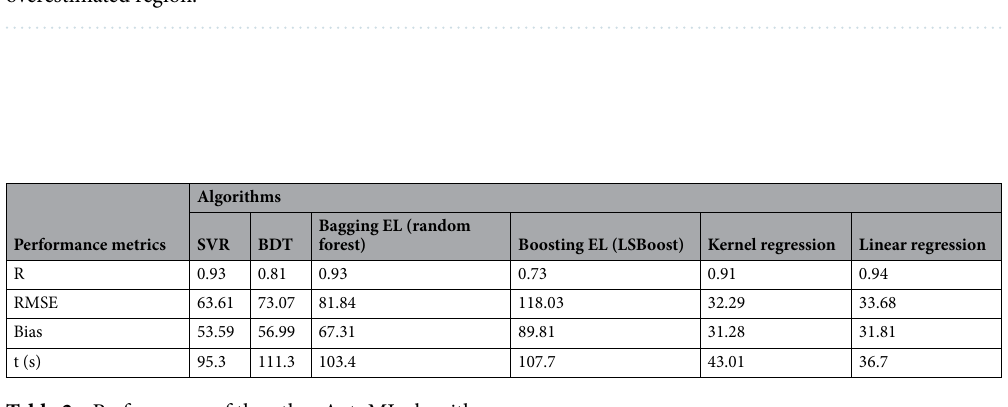
Table 2. Performance of the other AutoML